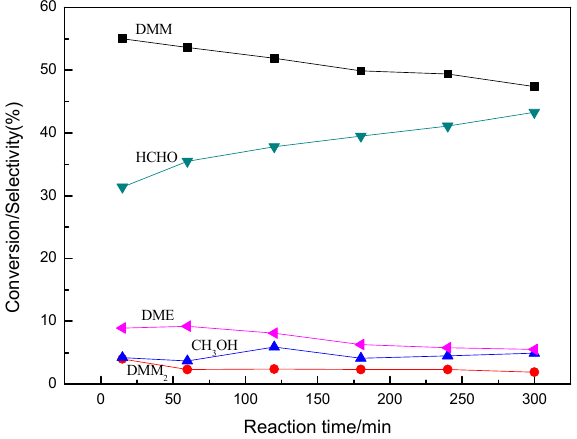
Figure 1. Effects of reaction time on the performance of 5%Re ‐ 30%PW 12 /CNTs.